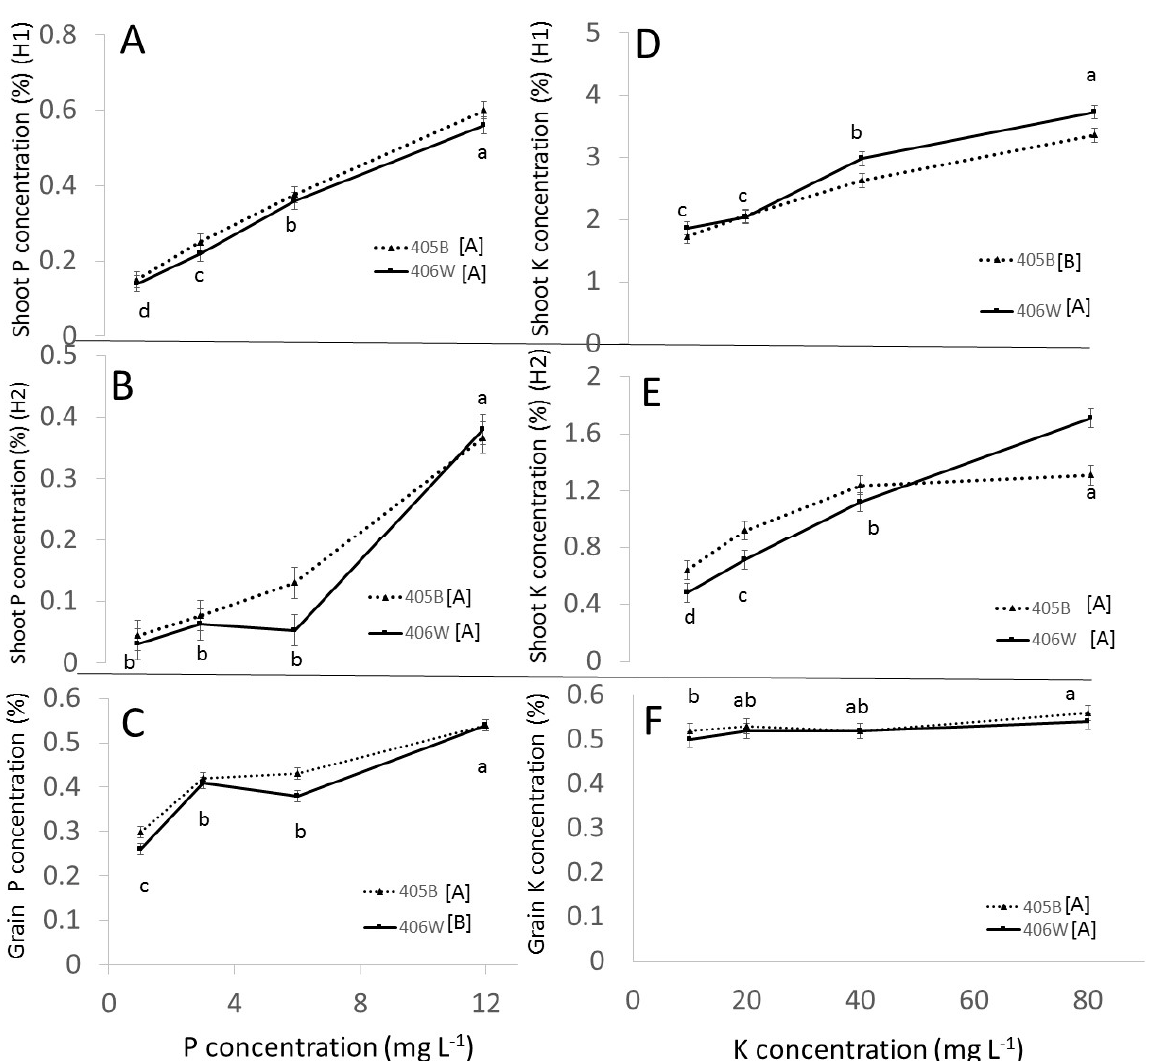
Figure 2. Shoot P concentration at flowering ( A ), shoot P concentration at maturity ( B ), and grain P concentration ( C ) in the winter pot experiment by P fertigation level. Shoot K concentration at flowering ( D ), shoot K concentration at maturity ( E ) and grain K concentration ( F ) in the winter pot experiment by K fertigation level. Dashed line represents 405B genotype, and solid line represents 406W genotype. Different letters represent significant (<0.05) differences for main effects. Lower case letters adjacent to the trend line represent the results of the Tukey test for nutrient concentration averaged across both genotypes, and capital letters adjacent to the legend represent the results of the Student- t test for the two different genotypes.